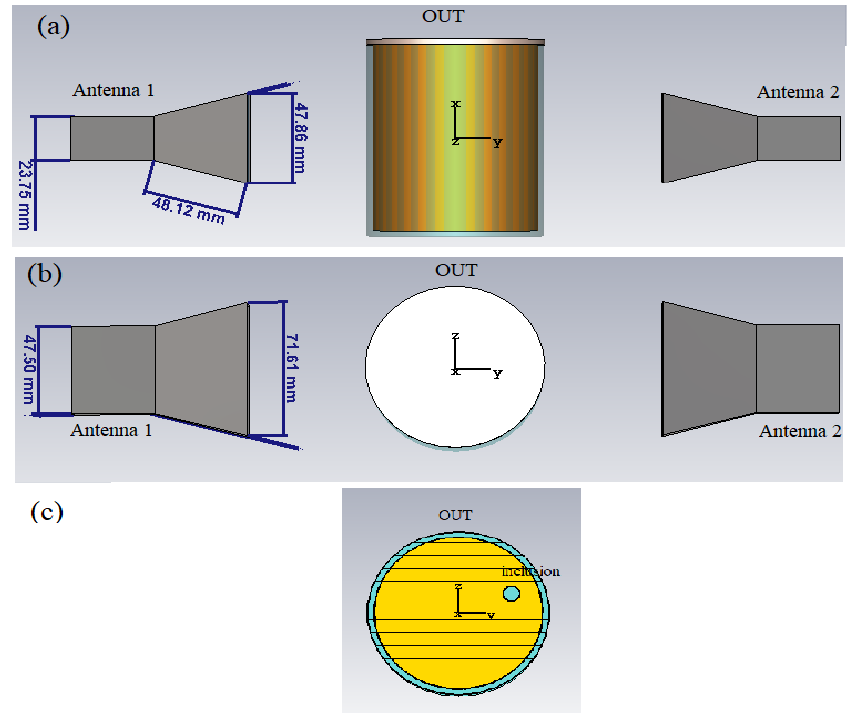
Figure 3. Numerical set up adopted in the simulations: ( a ) front view; ( b ) top view; ( c ) a cut of the OUT.